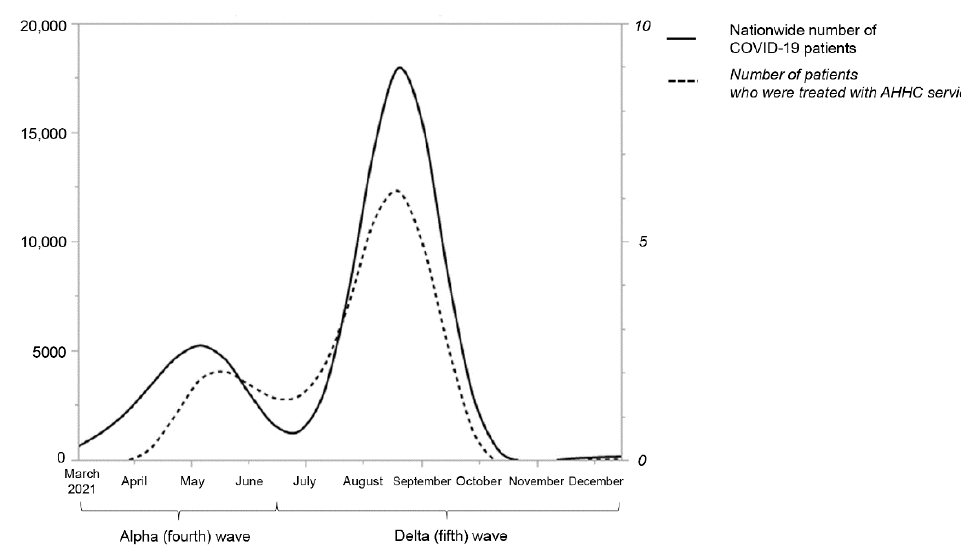
Figure 1. The number of COVID-19 patients treated by the after-hours home-call service and the nationwide number of COVID-19 patients. AHHC—after-hours house-call.